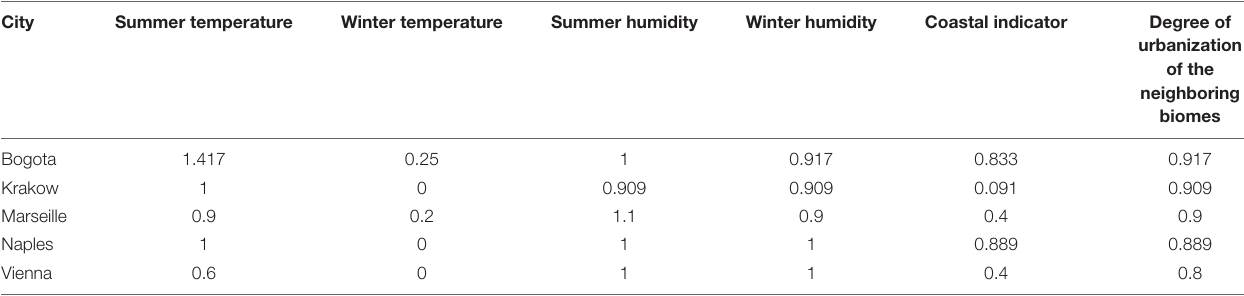
urbanization of the neighboring